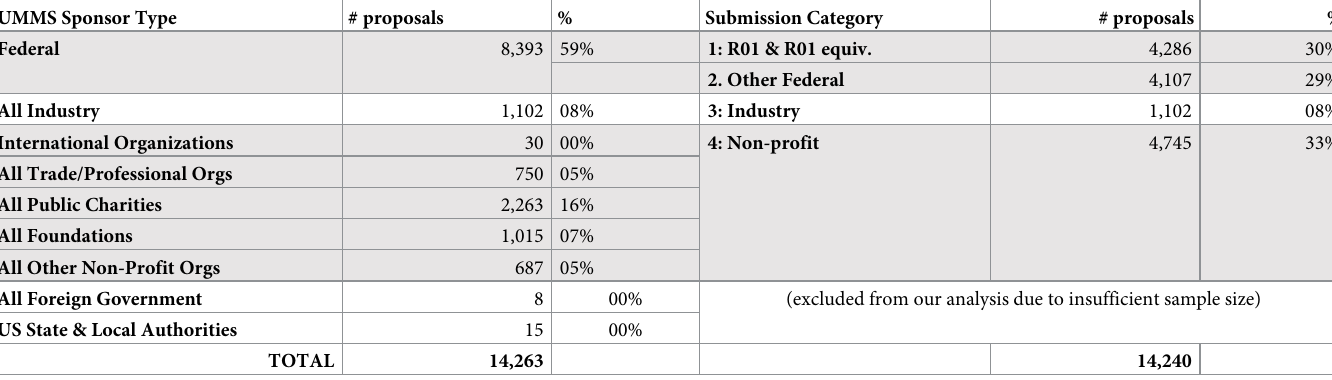
Table 2. Assignment of UMMS sponsor types into four submission categories